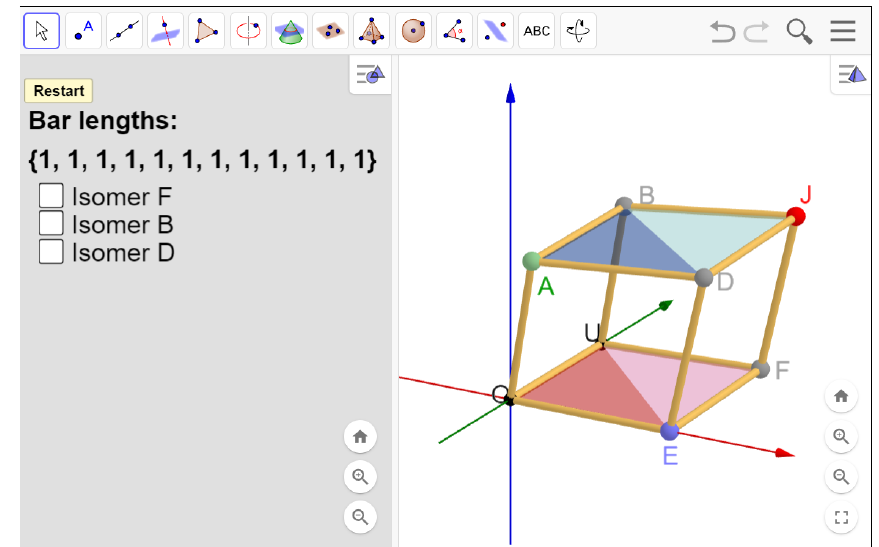
Figure 14. A GeoGebra cube with degrees of freedom